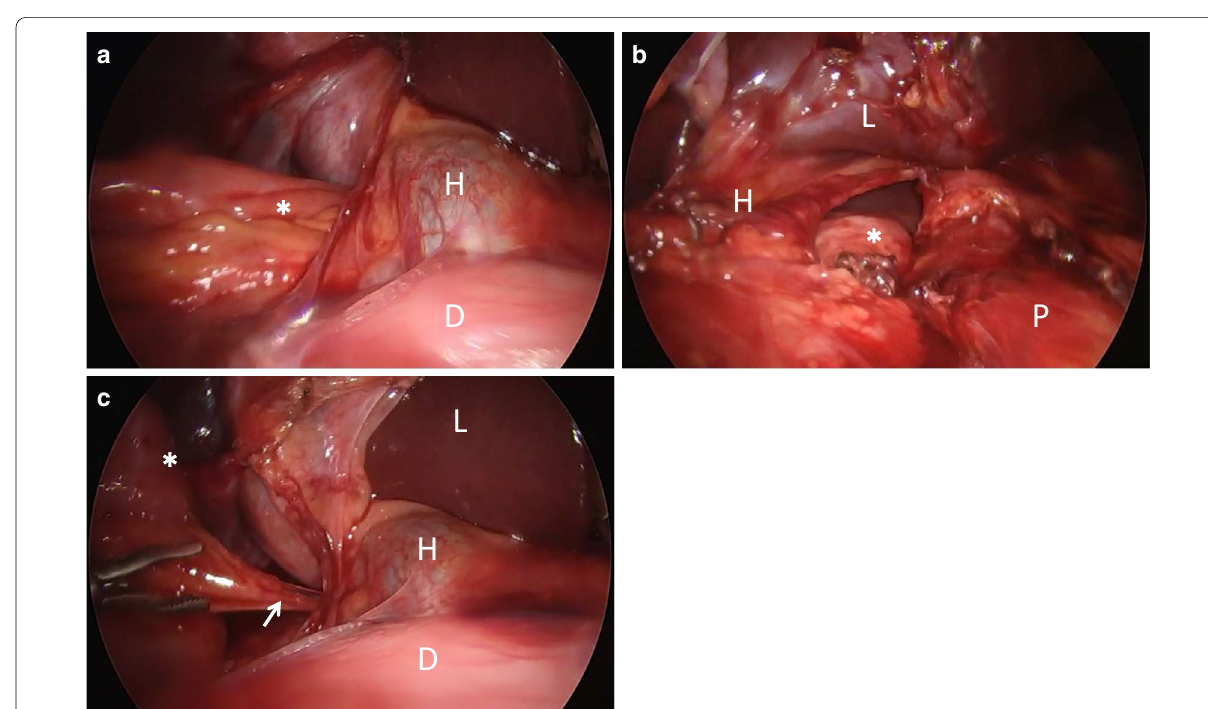
Fig. 3 Intraoperative laparoscopic views. a Small bowel (*) herniated through the foramen of Winslow. The bowel dilation reduced with the effect of the nasal tube before surgery. Due to adhesion between intra-omental tissue and herniated bowel, the herniated bowel was difficult to pull out from the foramen of Winslow. b The view shows the lesser sac opened by incising the lesser omentum. c The arrow shows one of the adhesions between the intra-omental tissue and herniated bowel. Duodenum, hepatoduodenal ligament, liver, and pancreas are labeled D, H, L, and P,